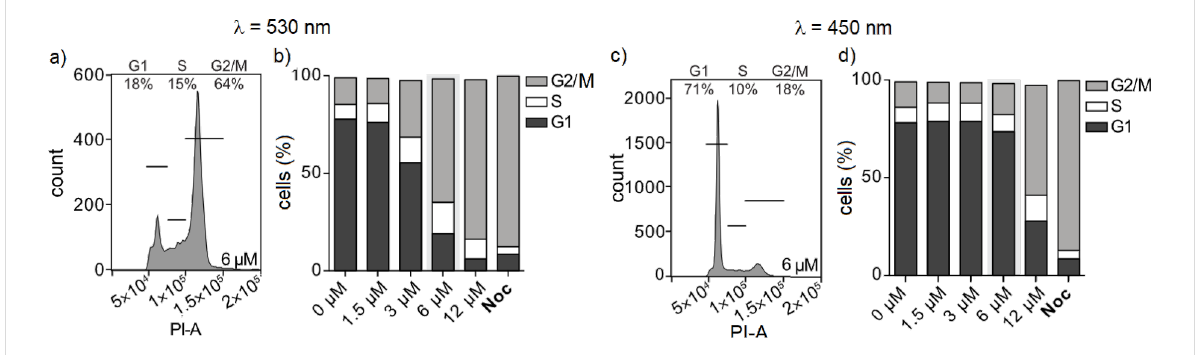
Figure 6: Cell cycle analysis of HITub-4 -treated cells. a) and b) ( Z )- HITub-4 caused significant G2/M arrest already at a concentration of 6 μ M ( λ = 530 nm). c) and d) Under irradiation at λ = 450 nm, where a majority of ( E )- HITub-4 was present, no mitotic arrest could be observed at compar- able concentrations. a) and c) Representative histograms showing cell cycle arrest, with population binning as indicated. In b) and d), nocodazole (Noc) was used as a positive control ( c = 1 μ